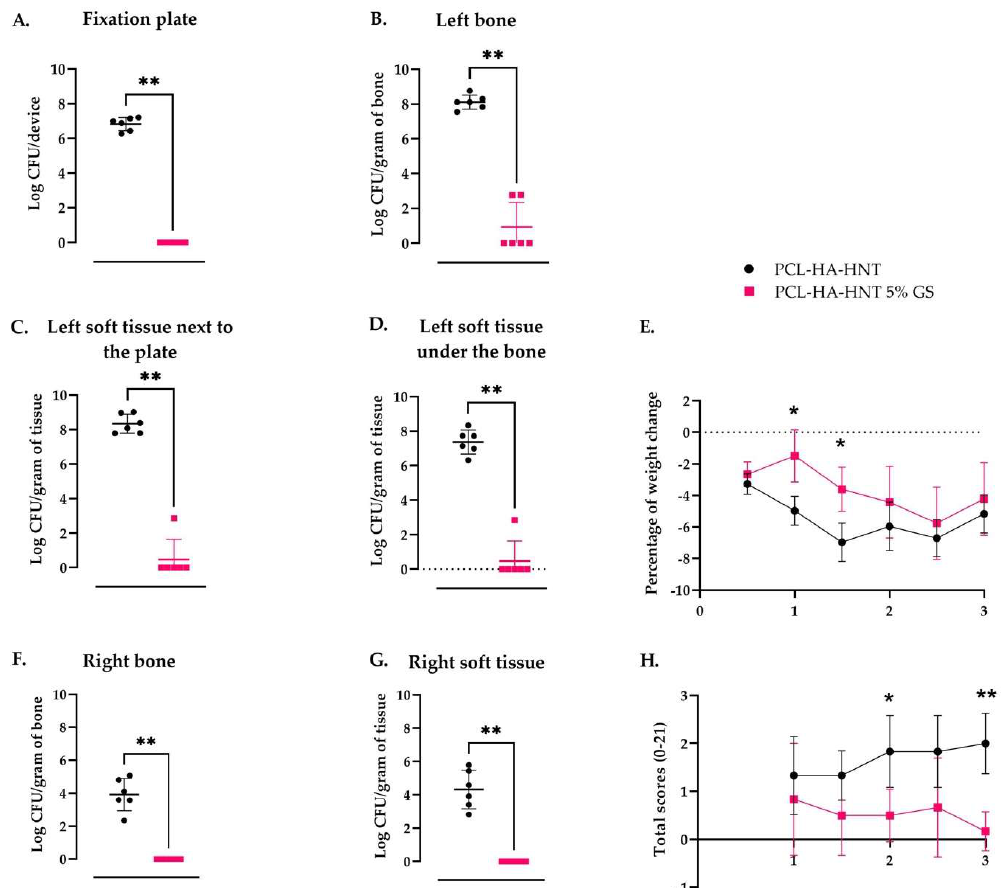
Figure 10. In vivo antimicobial activity in a murine fixation plate associated S. aureus bone infection of PCL-HA-HNT plates loaded with or without 5% GS on a fixation plate associated S. aureus bone infection in mice. Mouse femurs were fixed with a non-loaded PCL-HA-HNT plate or loaded with 5% of GS and then infected with 1 µL with 10 4 CFU of S. aureus JAR 06.01.31 in a hole of 0.5 mm drilled in the center of the bone. After 3 days, the number of viable bacteria on the plate, in the bone (right and left), in the surrounding tissue next to the plate and in tissue under the bone were determined. Results are indicating the logarithmic quantitative bacterial growth per device ( A ), fixation plate or gram of bone ( B ), left bone; ( F ), right bone or tissue ( C ) left soft tissue next to the plate; ( D ), left soft tissue under the bone, ( G ), right soft tissue; ( E ), percentage of weight loss; ( H ), total scores. n = 6 mice per group Note: * Indicates a p -value of 0.01 to 0.05, ** indicates a p -value of 0.001 to 0.01.